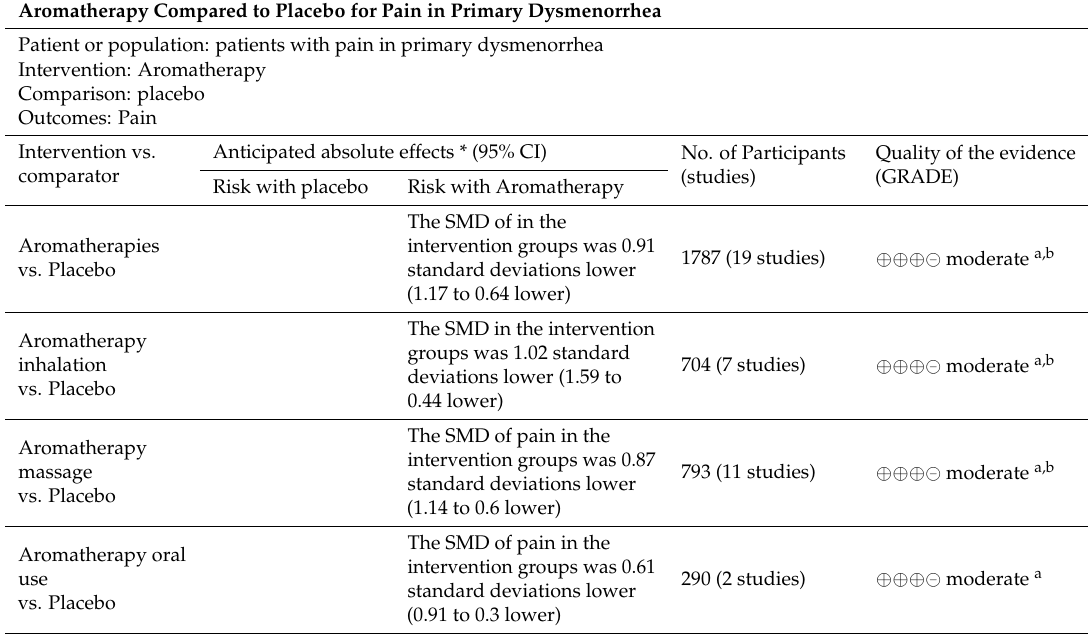
Table 2. Summary of findings.